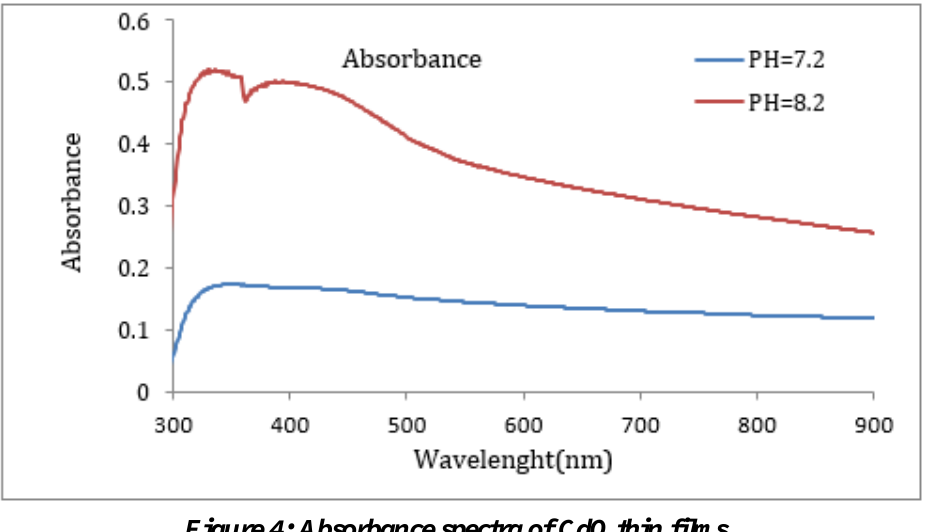
Figure 4: Absorbance spectra of CdO thin films.